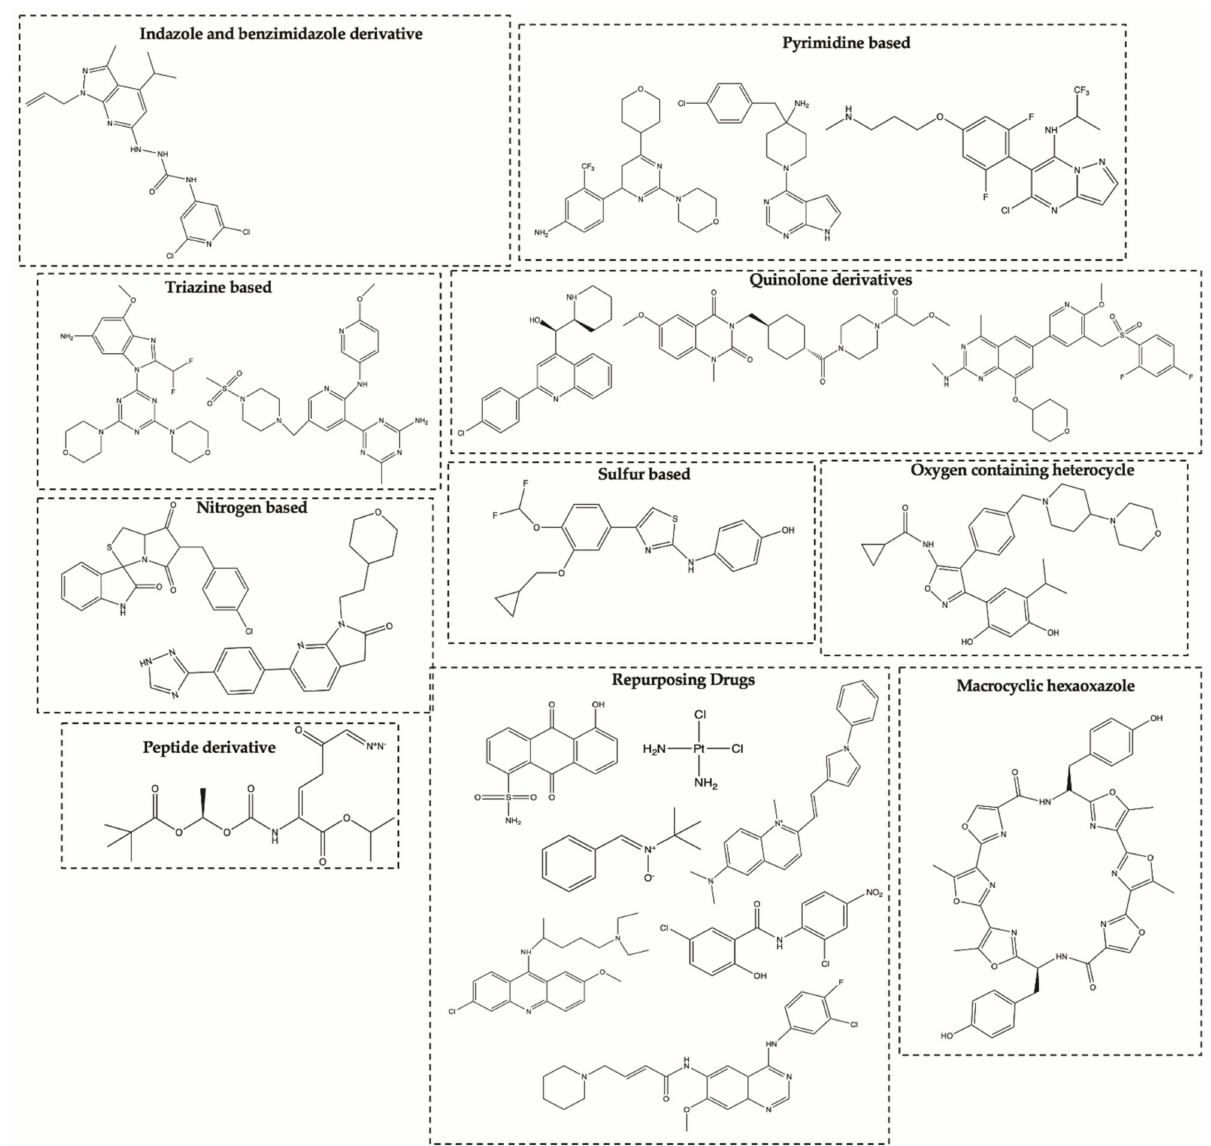
Figure 2. Synthetic compounds that have shown in vivo efficacy against